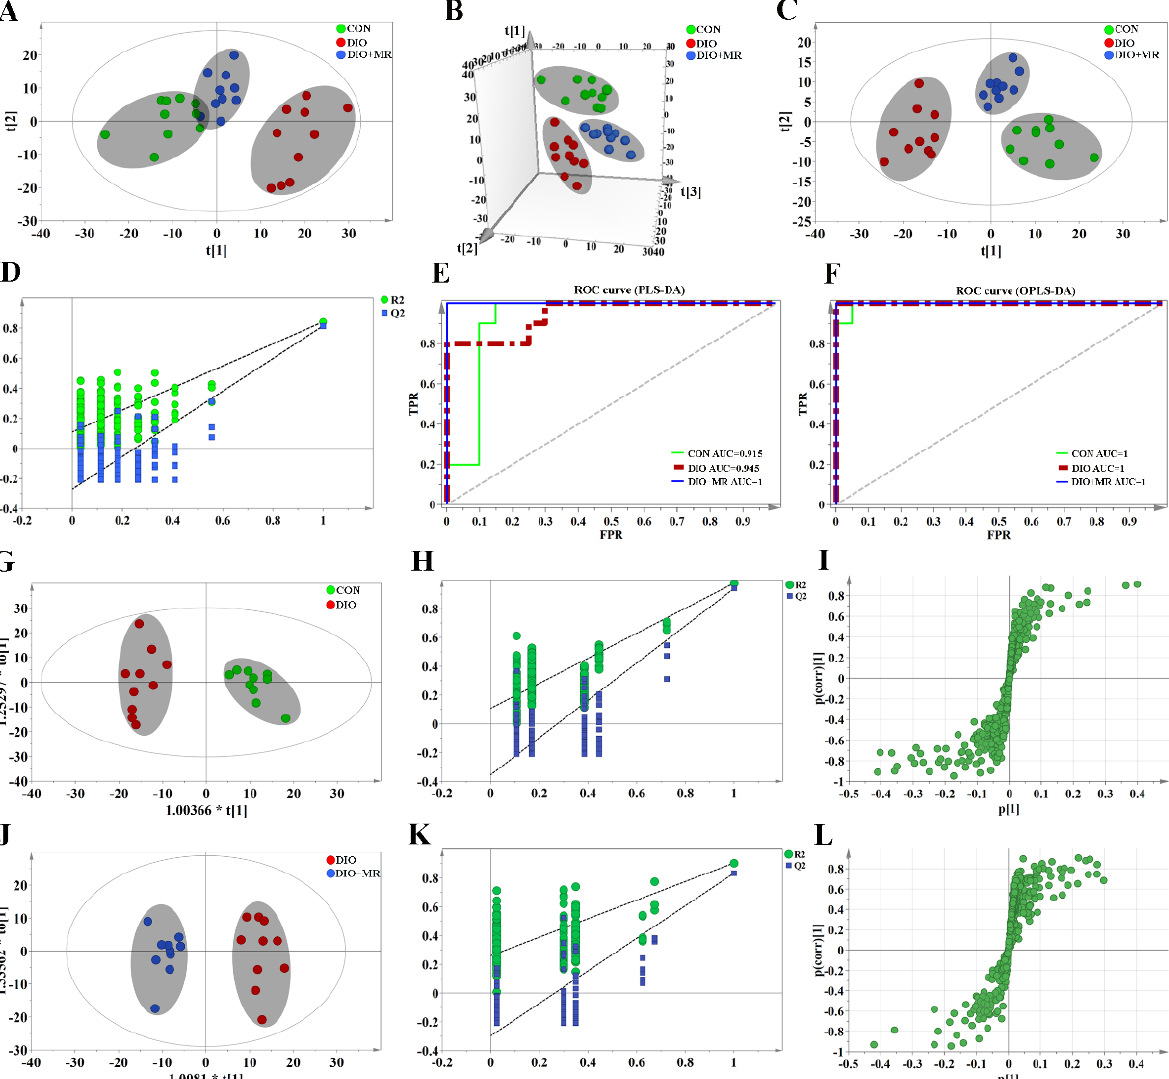
Figure 5. Multivariate statistical analysis based on the 1 H-NMR spectra of spleen metabolite data acquired from the CON (green circles), DIO (red circles), and DIO + MR (blue circles) mice. ( A ), 2D-PCA score plots (R 2 X = 0.638, Q 2 = 0.488); ( B ), 3D-PCA score plots (R 2 X = 0.821, Q 2 = 0.707); ( C ), PLS-DA score plots (R 2 X = 0.570, R 2 Y = 0.758, Q 2 = 0.548); ( D ), PLS-DA validation plots; ( E ), ROC curve (PLS-DA); ( F ), ROC curve (OPLS-DA); ( G ), OPLS-DA score plots (DIO vs. CON; R 2 X = 0.584, R 2 Y = 0.963, Q 2 = 0.834); ( H ), OPLS-DA validation plots (DIO vs. CON); ( I ), S-plot (DIO vs. CON); ( J ), OPLS-DA score plots (DIO + MR vs. DIO; R 2 X = 0.608, R 2 Y = 0.934, Q 2 = 0.812); ( K ), OPLS-DA validation plots (DIO + MR vs. DIO); ( L ), S-plot (DIO + MR vs. DIO).